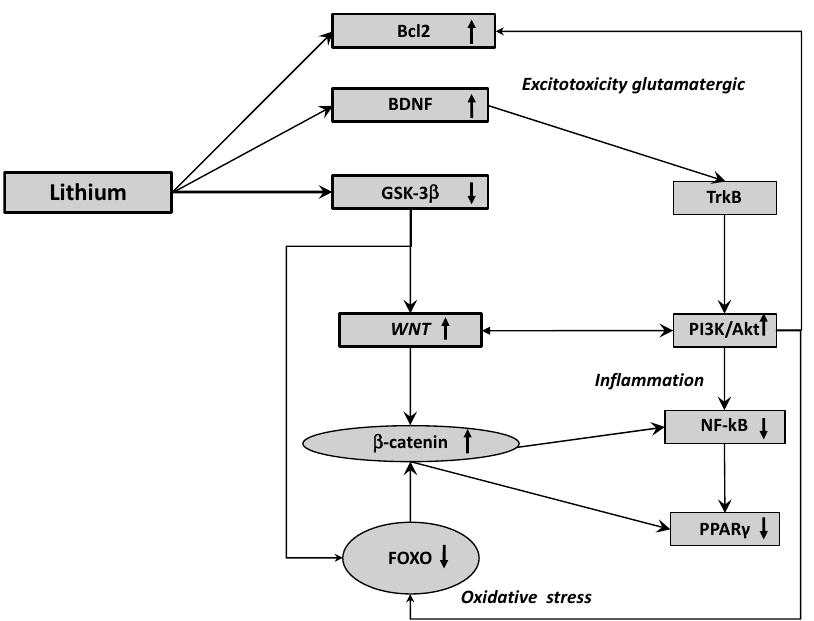
Figure 2. Underlying molecular mechanisms of lithium actions in glaucoma. BDNF: brain-derived neurotrophic factor; FOXO: forkhead box class O; GSK-3 β : glycogen synthase kinase-3 β ; LRP 5/6: low-density lipoprotein receptor-related protein 5/6; NF- κ B: nuclear factor-kappa B; PI3K-Akt: phosphatidylinositol 3-kinase-protein kinase B; TrkB: tropomyosin receptor kinase B. Lithium can activate both Bcl2 and BNDF to diminish the excitotoxicity glutamate pathway.